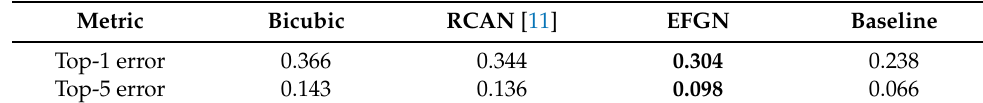
Figure 10. Images from ImageNet CLS-LOC validation dataset. Table 5. ResNet-50 object recognition performance. The original images are served as baseline. Best results are shown in bold.